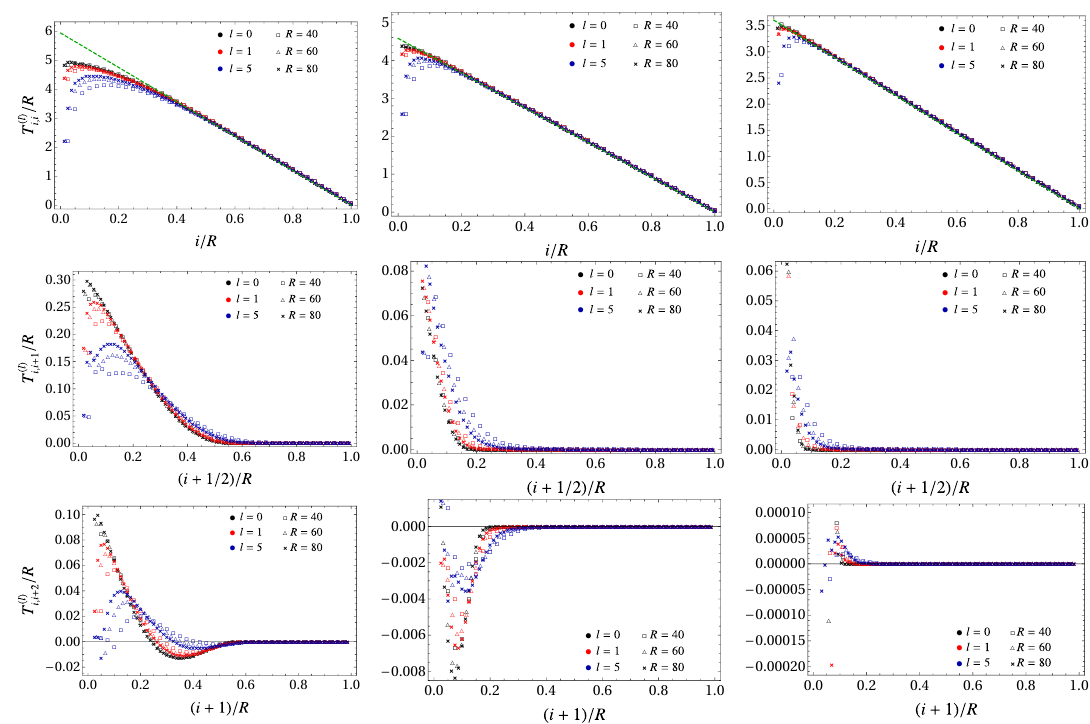
Figure 8. Short-range couplings in the matrices T ( l ) /R (see (3.2) and (3.5)) when ω > 0 and d = 3 , for ω = 1 (left panels), ω = 3 (middle panels) and ω = 5 (right panels), for some small l ’s and different sizes R . The dashed green lines in the top panels correspond to